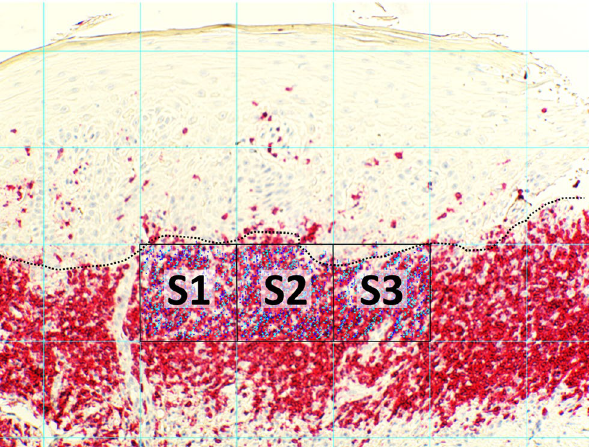
Figure 6. Analysis of T lymphocyte subsets in OLP lesions. The T- cell infiltrate of mucosal sections was quantified by microscopical images (Axiostar, Zeiss, Jena, Germany) in combination with Cell^D (Soft Imaging System, Berlin, Germany) and ImageJ software (freeware). T cells were counted at a 100x magnification. After generating a grid (ImageJ software; area per point: 50.000 pixels^2), all stained T- cells were counted in three squares adjacent to basal membrane zone (ImageJ, cell counter) and their proportion of all infiltrating cells was determined